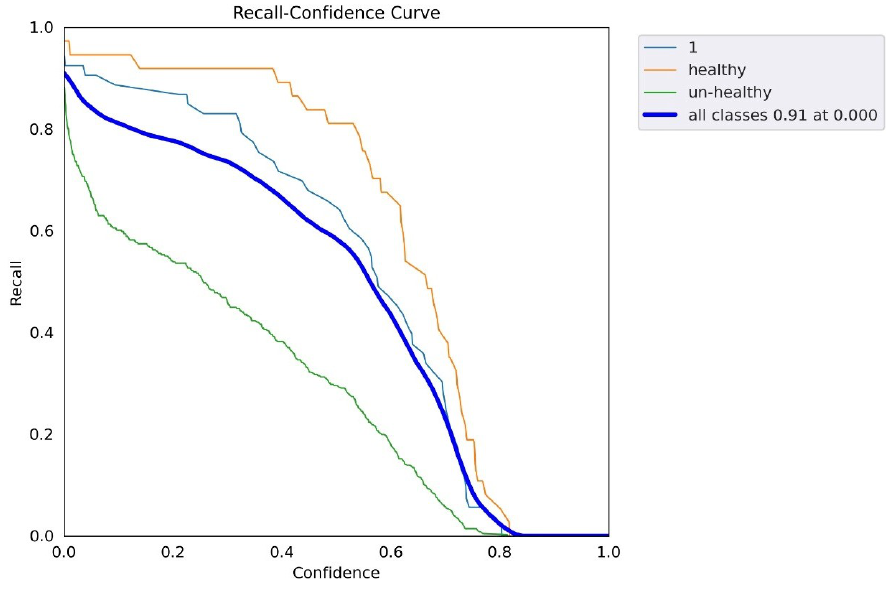
Figure 27. Confidence according to R Graph: Across all experiments, recall growth was compared and classified by training technique. It provided a substitute for the precision–recall